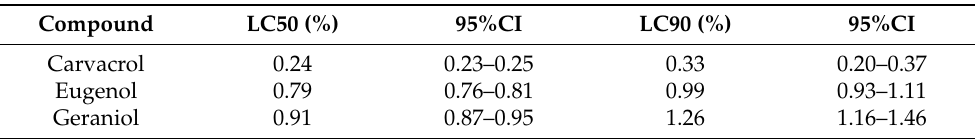
Table 2. Concentrations of three terpenes required to kill 50% and 90% of Sarcoptes mites at 30 min postexposure. Figure 1. Survival curves of Sarcoptes scabiei mites exposed to 5%, 1%, and 0.5% solutions of six terpenes.